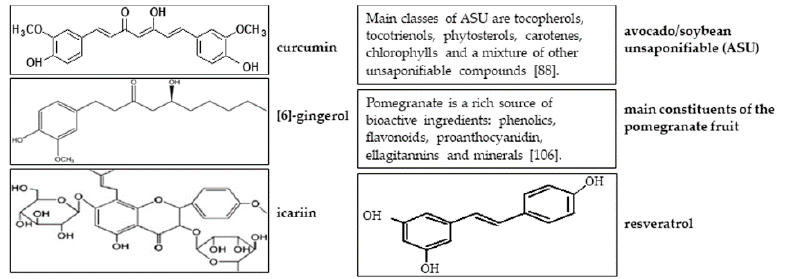
Figure 1. Structures of natural products with potential for cartilage regeneration, tissue engineering (TE), and the prevention and treatment of joint diseases.